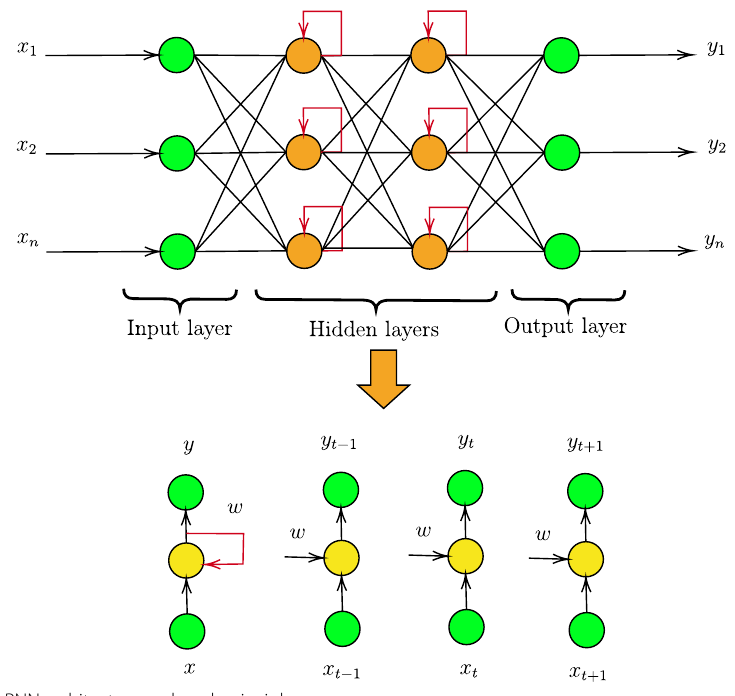
Fig. 14 RNN architecture and work